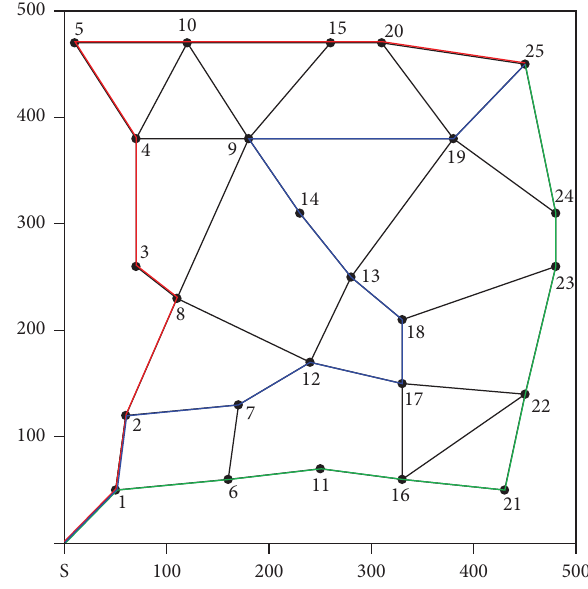
Figure 7: Network representing a suburban area, served by three lines in a TFS.